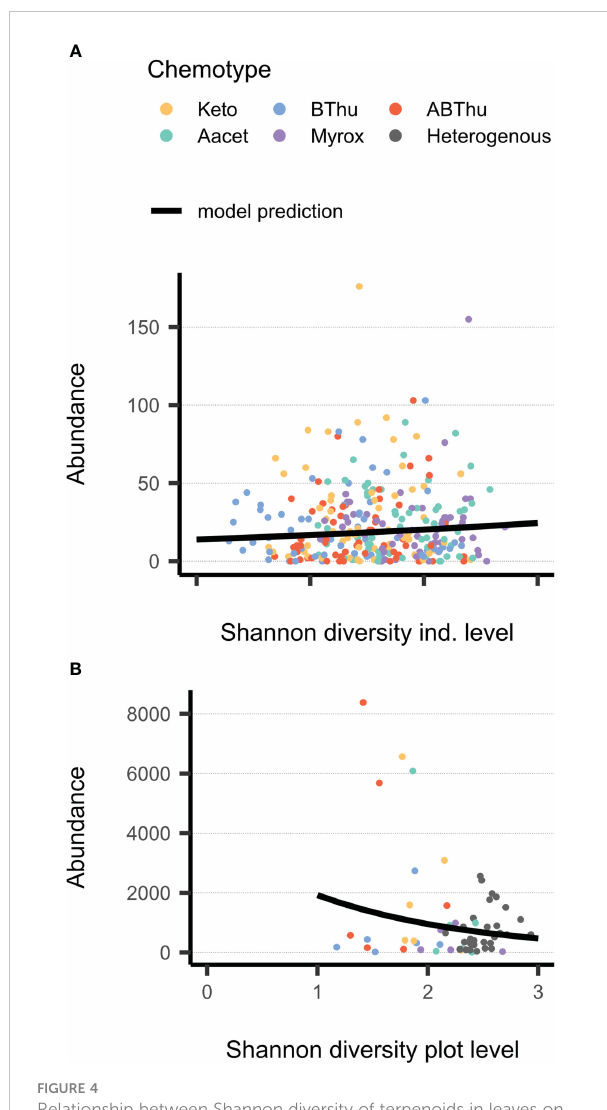
FIGURE 4 Relationship between Shannon diversity of terpenoids in leaves on (A) plant individual level (Hs ind ) or (B) plot level (Hs plot ) and total count of aphids (winged and unwinged) in June 2021 on Tanacetum vulgare plants of fi ve different chemotypes grown in plots of fi ve individuals of the same (homogenous) or different (heterogenous) chemotypes (Keto, artemisia ketone chemotype; BThu, b -thujone chemotype; ABThu, a -/ b -thujone chemotype; Aacet, artemisyl acetate/artemisia ketone/artemisia alcohol chemotype; Myrox, ( Z )- myroxide/santolina triene/artemisyl acetate chemotype). (A) Count of Macrosiphoniella tanacetaria on every individual plant; n plants = 55-60 per chemotype. (B) Cumulative count of Uroleucon tanaceti for every plot; n plots = 5-6 (per homogenous plots) or 30 (heterogenous